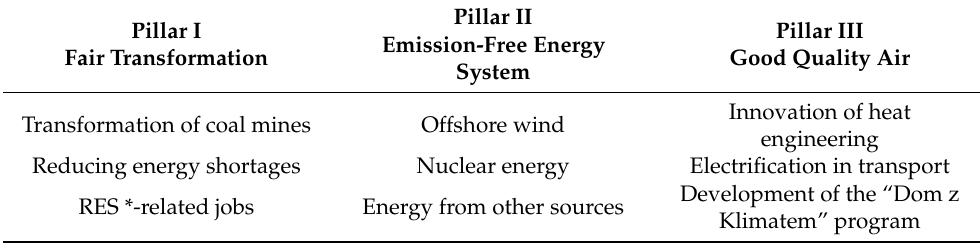
Table 1. Three pillars of the Polish energy transformation [14].